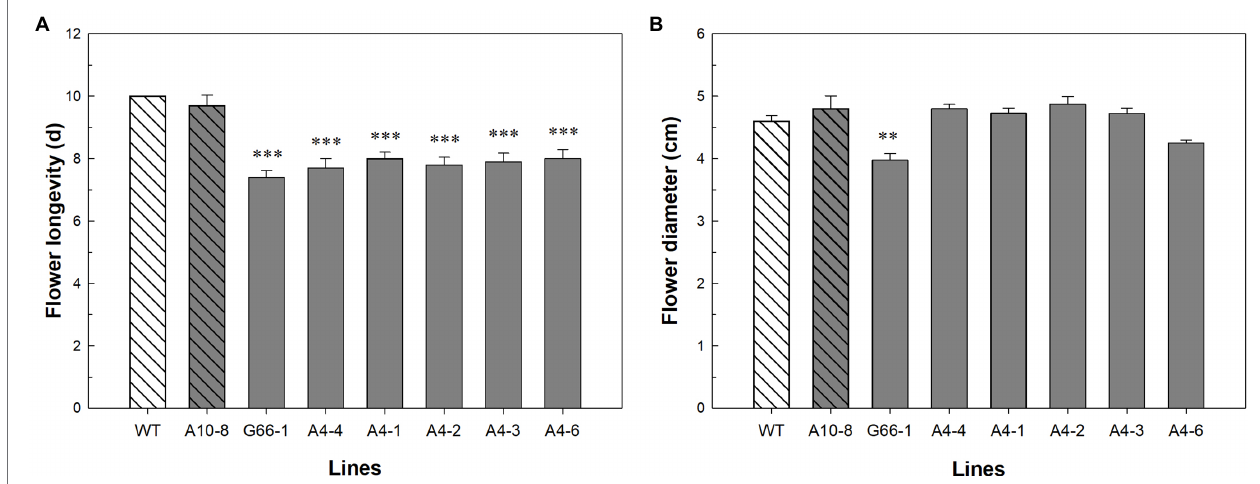
FIGURE 3 | Flower phenotypic evaluation of Petunia × hybrida ‘Mitchell Diploid’ wild-type plant (WT), non-mutated regenerated line A10-8, and PhATG6 -KO lines. (A) Flower longevity ( n = 10). (B) Flower diameter ( n = 4). Bars represent the means of the measurements ± standard error, and bars with stars indicate a